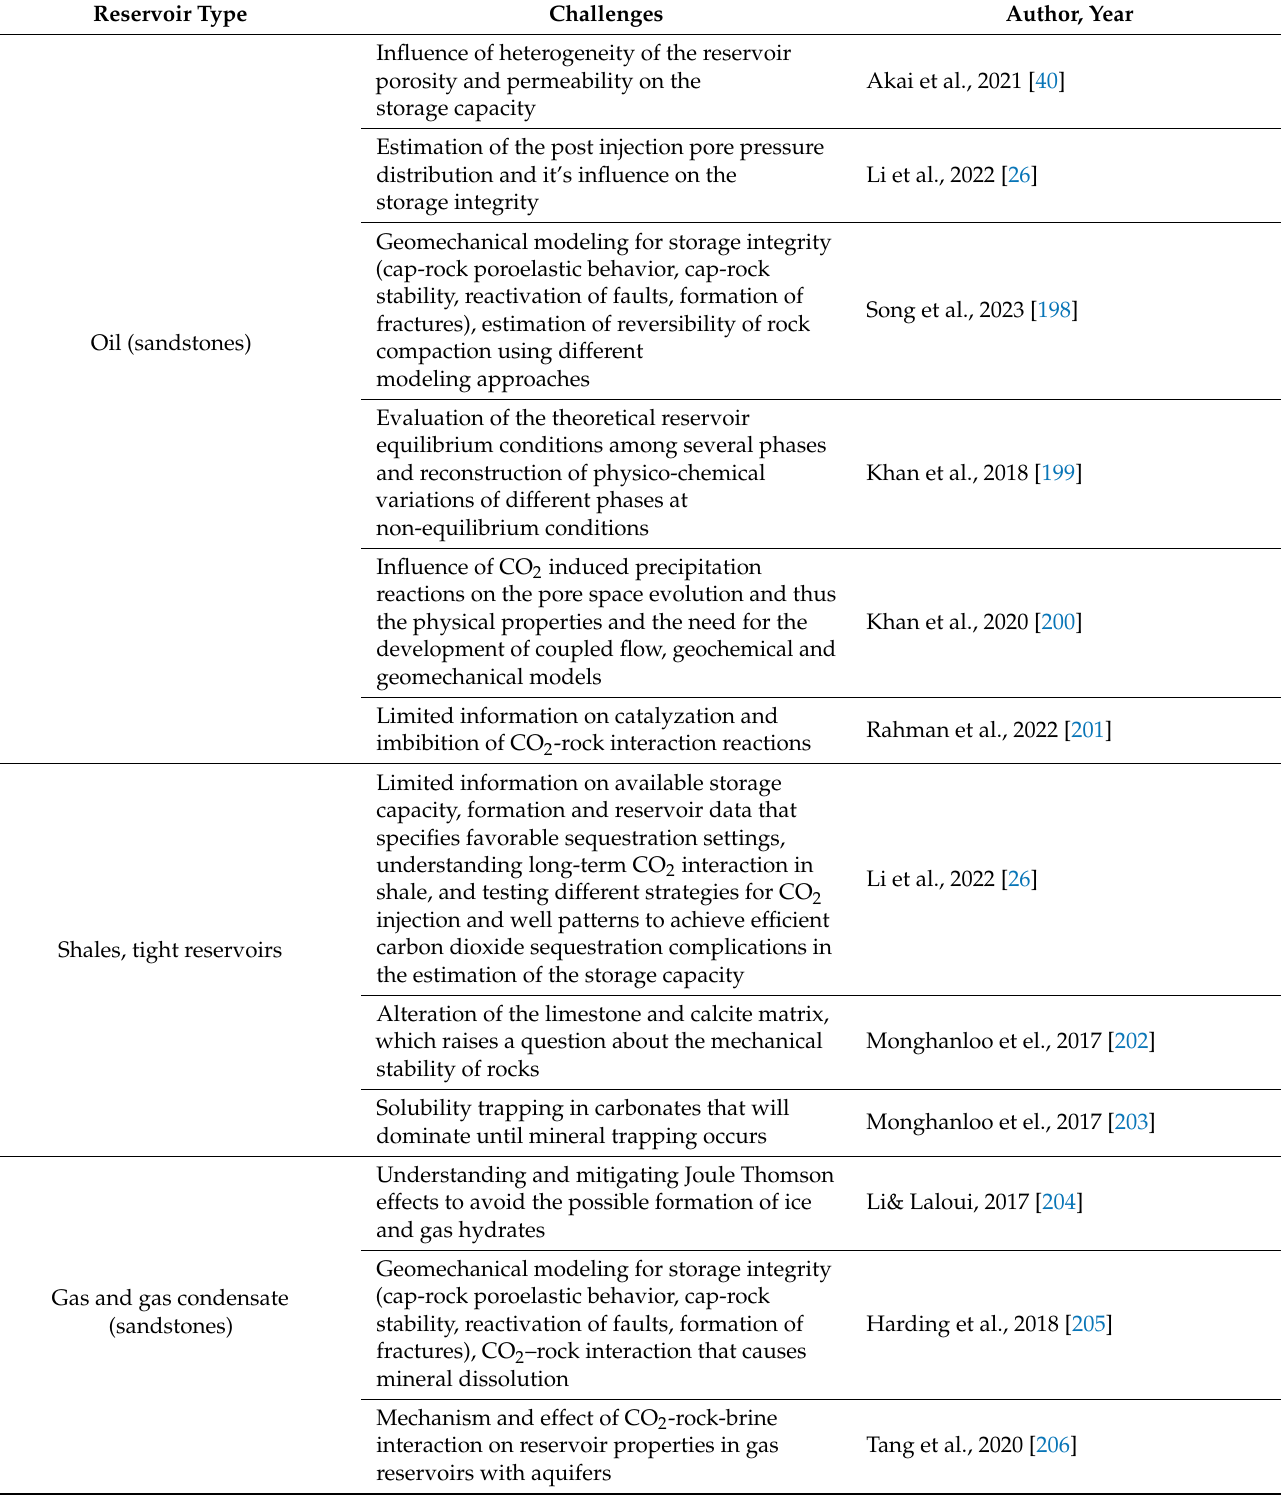
Table 3. Main trends in the most recent